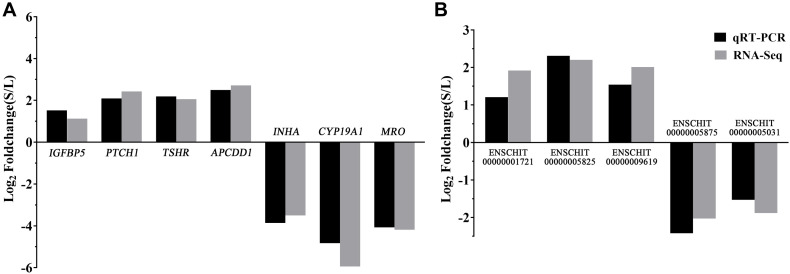
Validation of the DEmRNAs and DElncRNAs by qPCR. (A) The qRT-PCR results of the DEmRNAs were compared with the RNA-Seq. (B) The qRT-PCR results of the DElncRNAs were compared with the RNA-Seq. Black: qRT-PCR; Gray: RNA-Seq. In each group, 4 samples were analyzed.